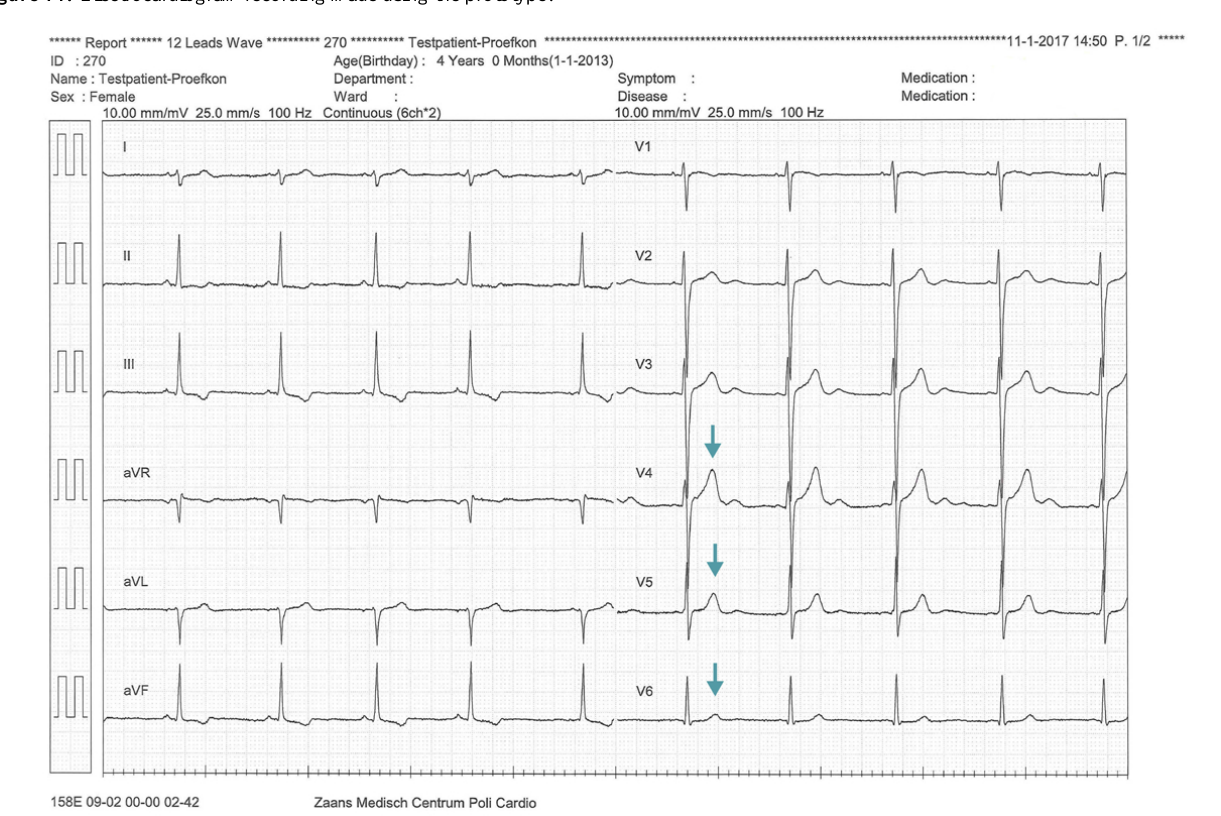
Figure 14. Electrocardiogram recording made using the